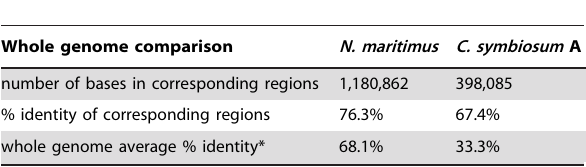
Table 3. Whole genome nucleotide identity comparisons between N. limnia , N. maritimus , and C. symbiosum A